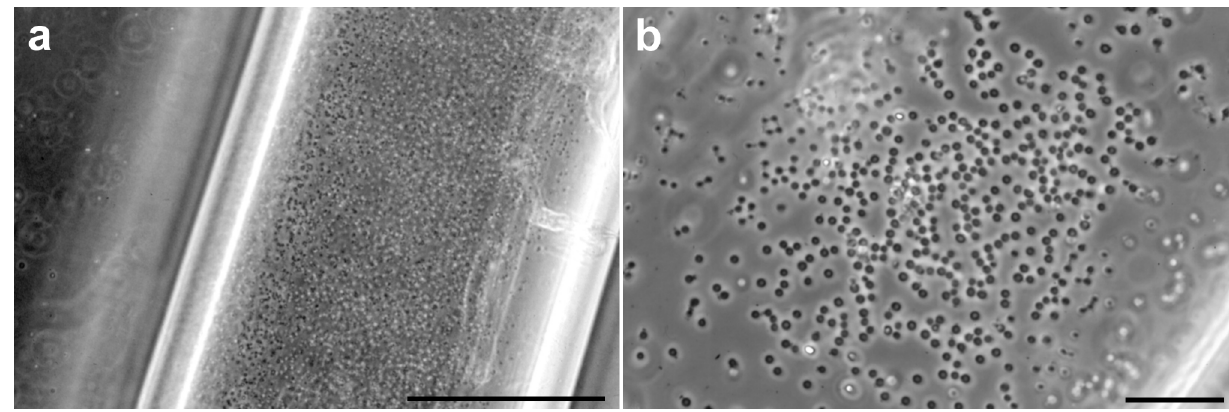
Figure 1. Light micrographsof cellulosecapillarytubes, inoculated with Ignicoccus , (a) after incubation for 36 h, bar = 100 µm; and (b) after incu- bation for 28 h, bar = 20 µm.